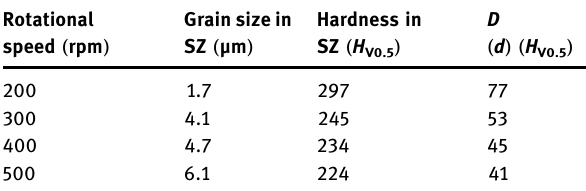
Table 2: Values of D ( d ) calculated by equation ( 1 )